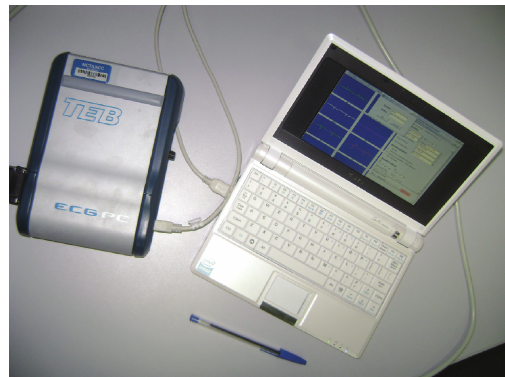
Figure 3: Hardware equipment used by the